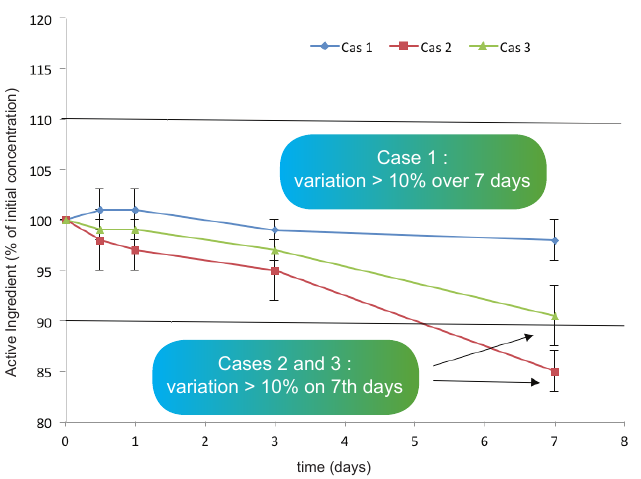
Figure 8: Evolution in concentration of active ingredient: expression of